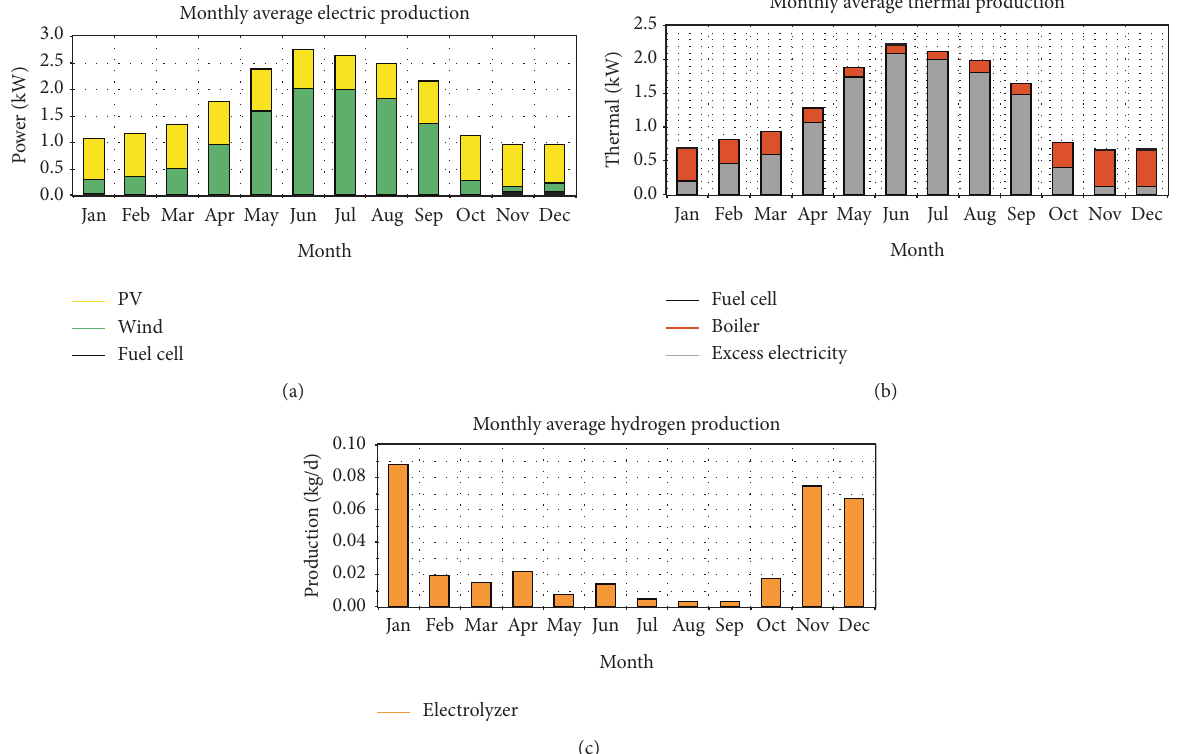
Figure 15: Monthly average production. (a) Electricity. (b) Thermal energy. (c)